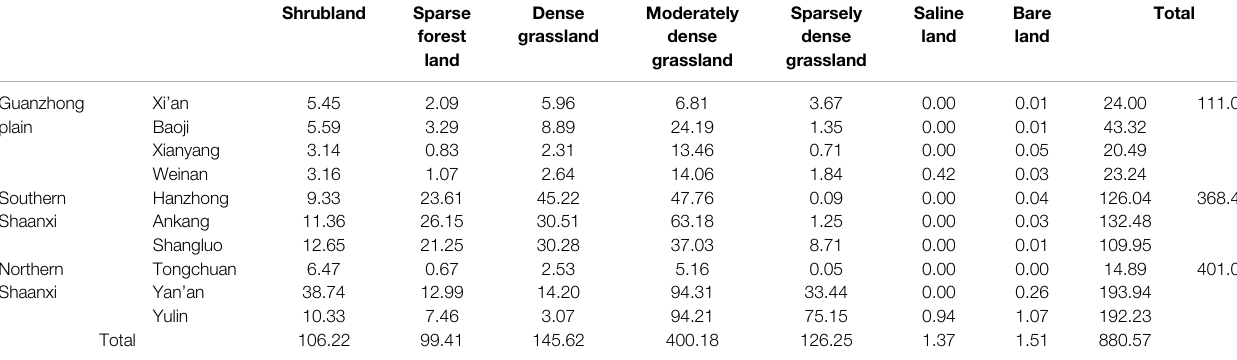
TABLE 2 | Statistical results of marginal land suitable for growing Jerusalem artichoke in each city of Shaanxi Province with the unit 1.00 × 10 8 m 2